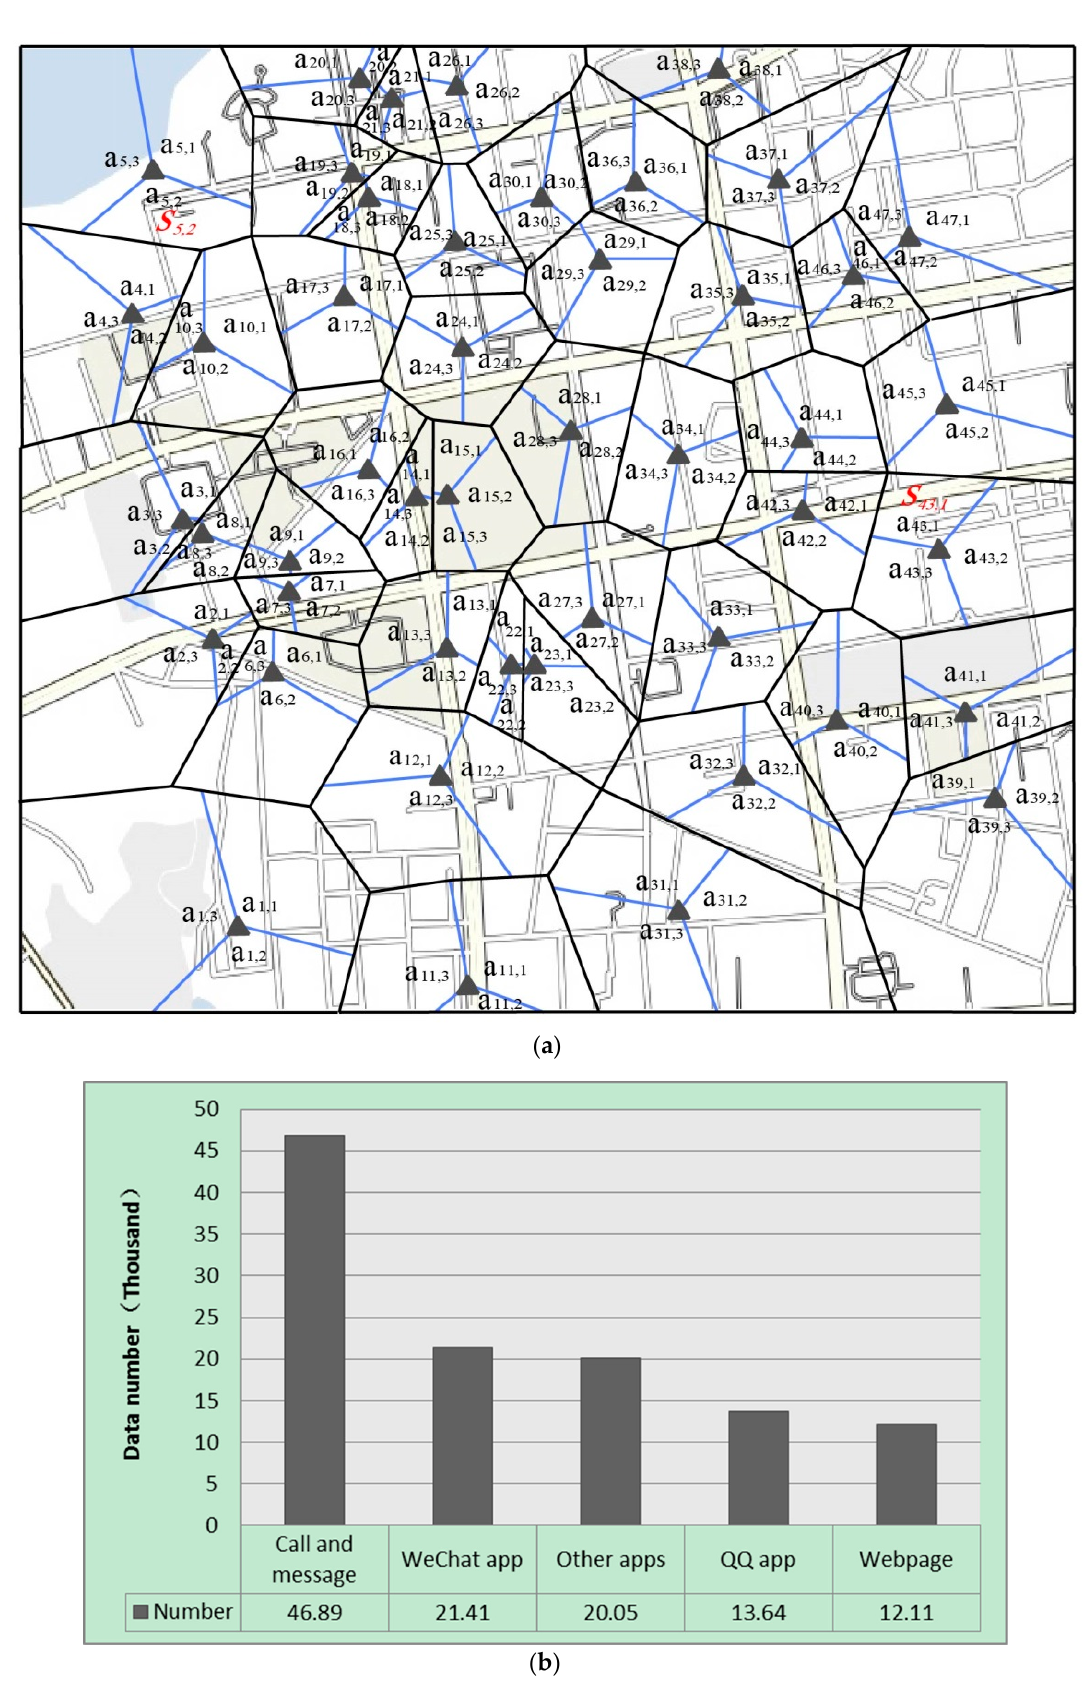
Figure 6. Input data. ( a ) The distribution of traffic analysis zones (TAZs) in an urban area; ( b ) Data number of different types.